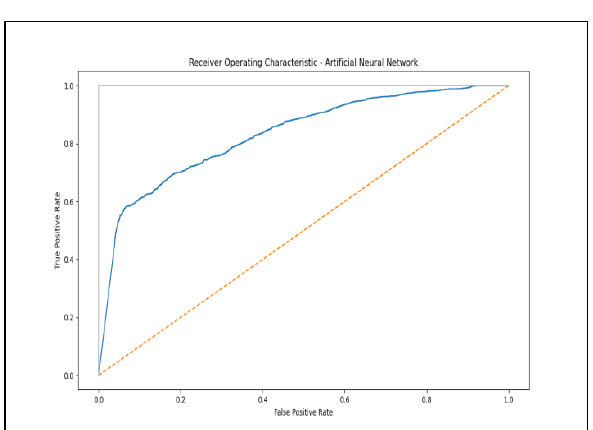
Figure 16: Random Forest Receiver operating characteristic.